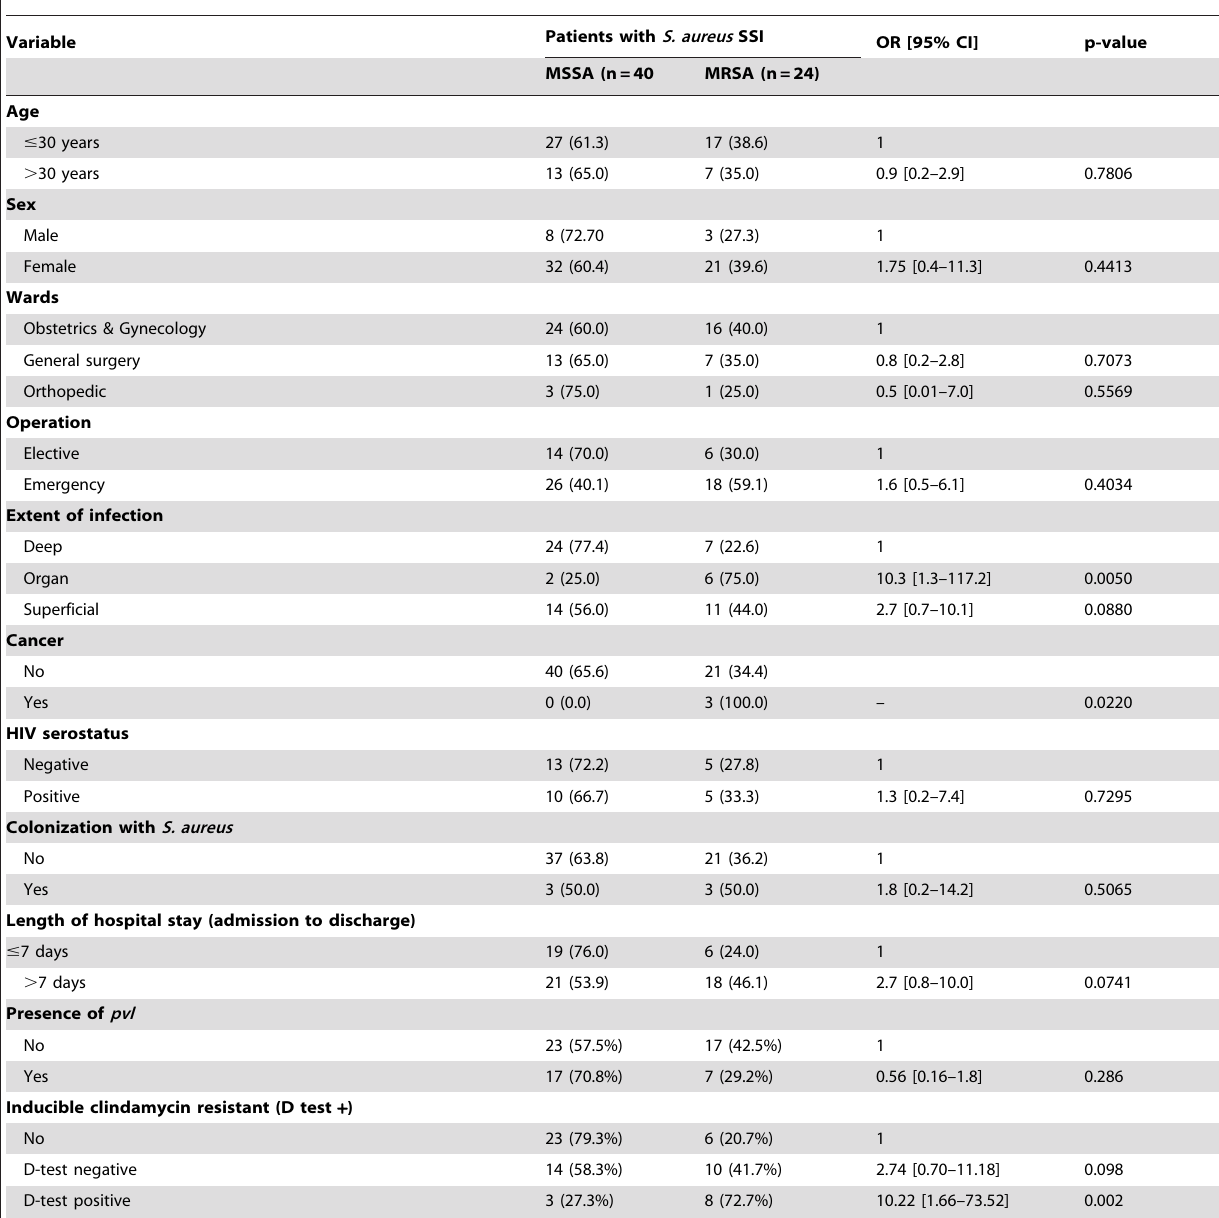
Table 3. Association between MRSA/MSSA with clinico-demographic characteristics among patients with SSI.